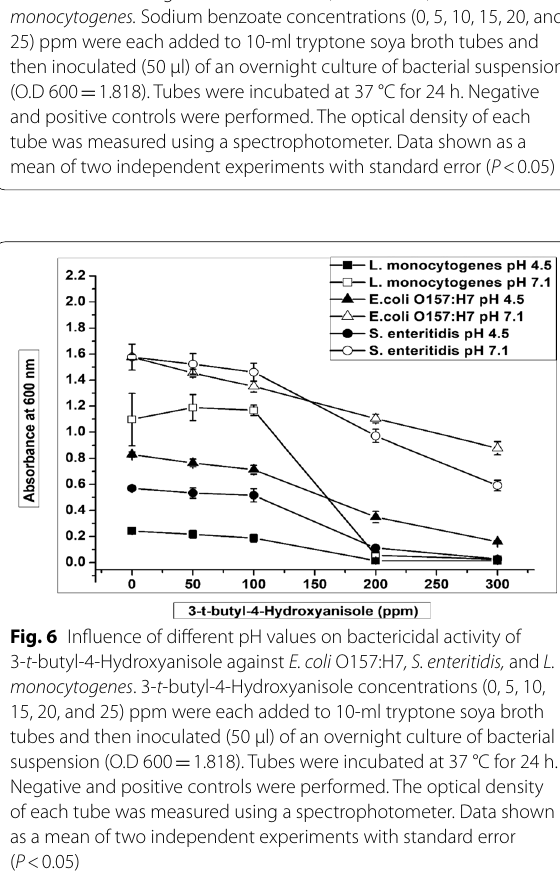
S. enteritidis followed by a steady pattern at 300 ppm. In the case of L. monocytogenes , a gradual reduction in the growth occurred at a minimum inhibition concentration of 200 ppm (Fig. 6).